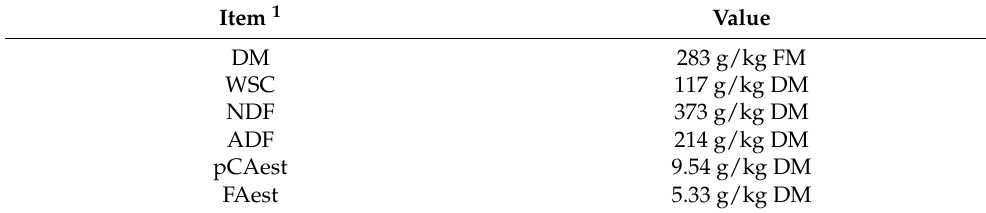
Table 1. The chemical composition of whole corn plant before ensiling. Item 1